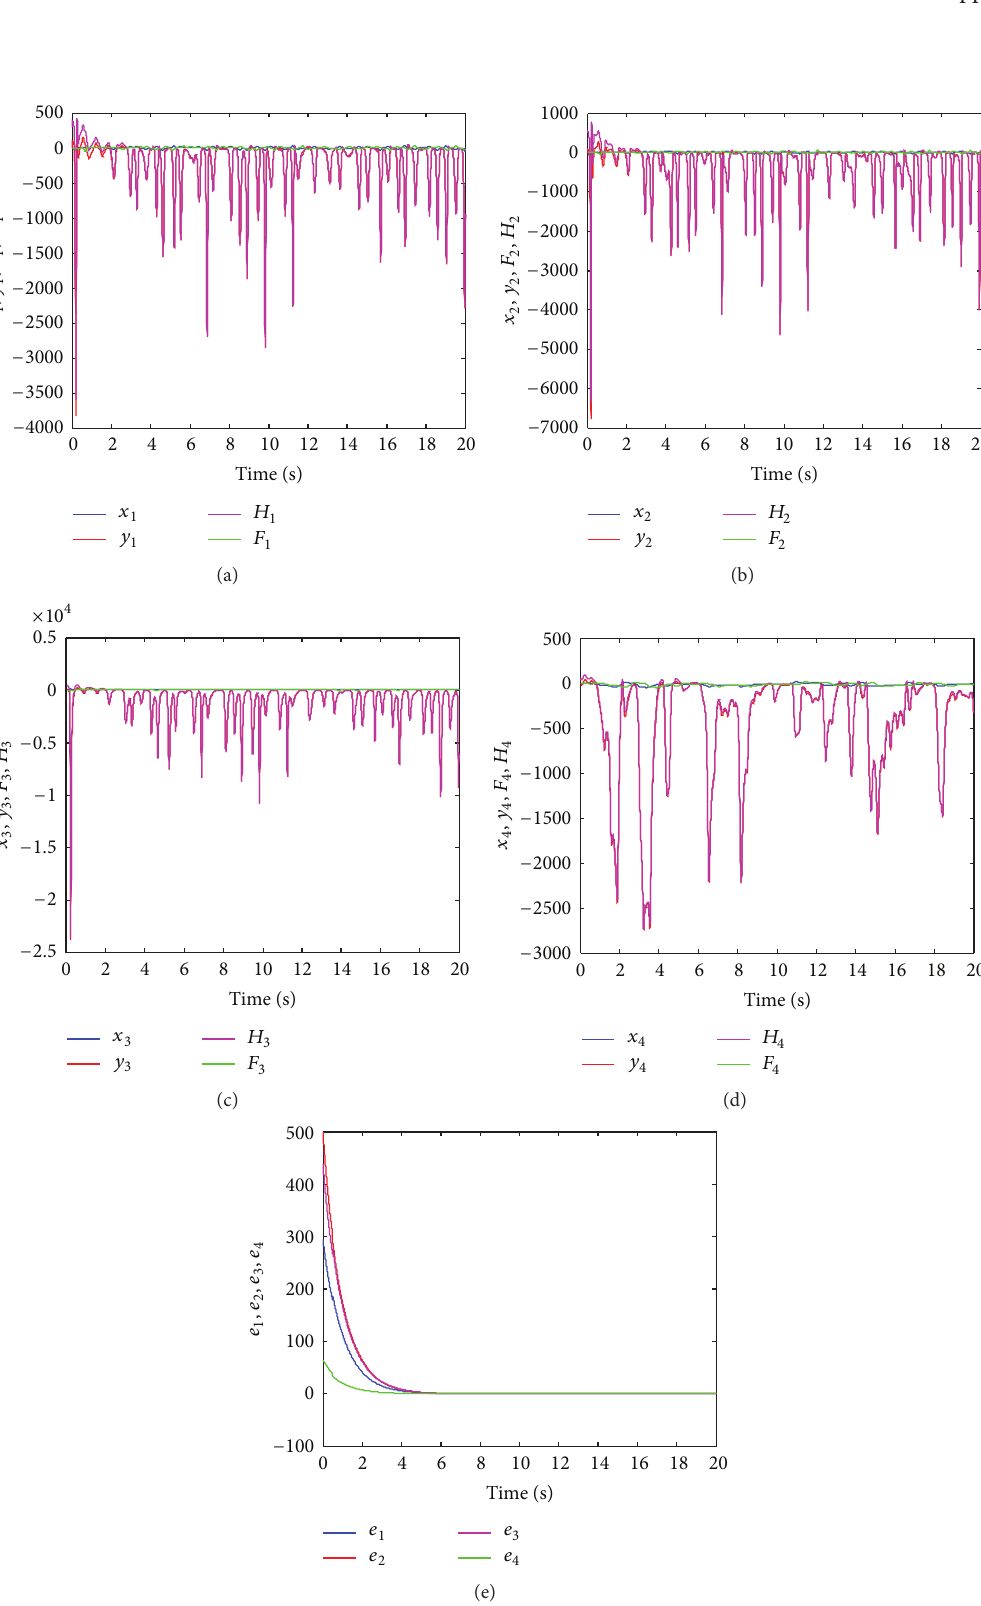
Figure 6: Time histories of states, state errors, 𝐹 1 , 𝐹 2 , 𝐹 3 , 𝐹 4 , 𝐻 1 , 𝐻 2 , 𝐻 3 , and 𝐻 4 for Case